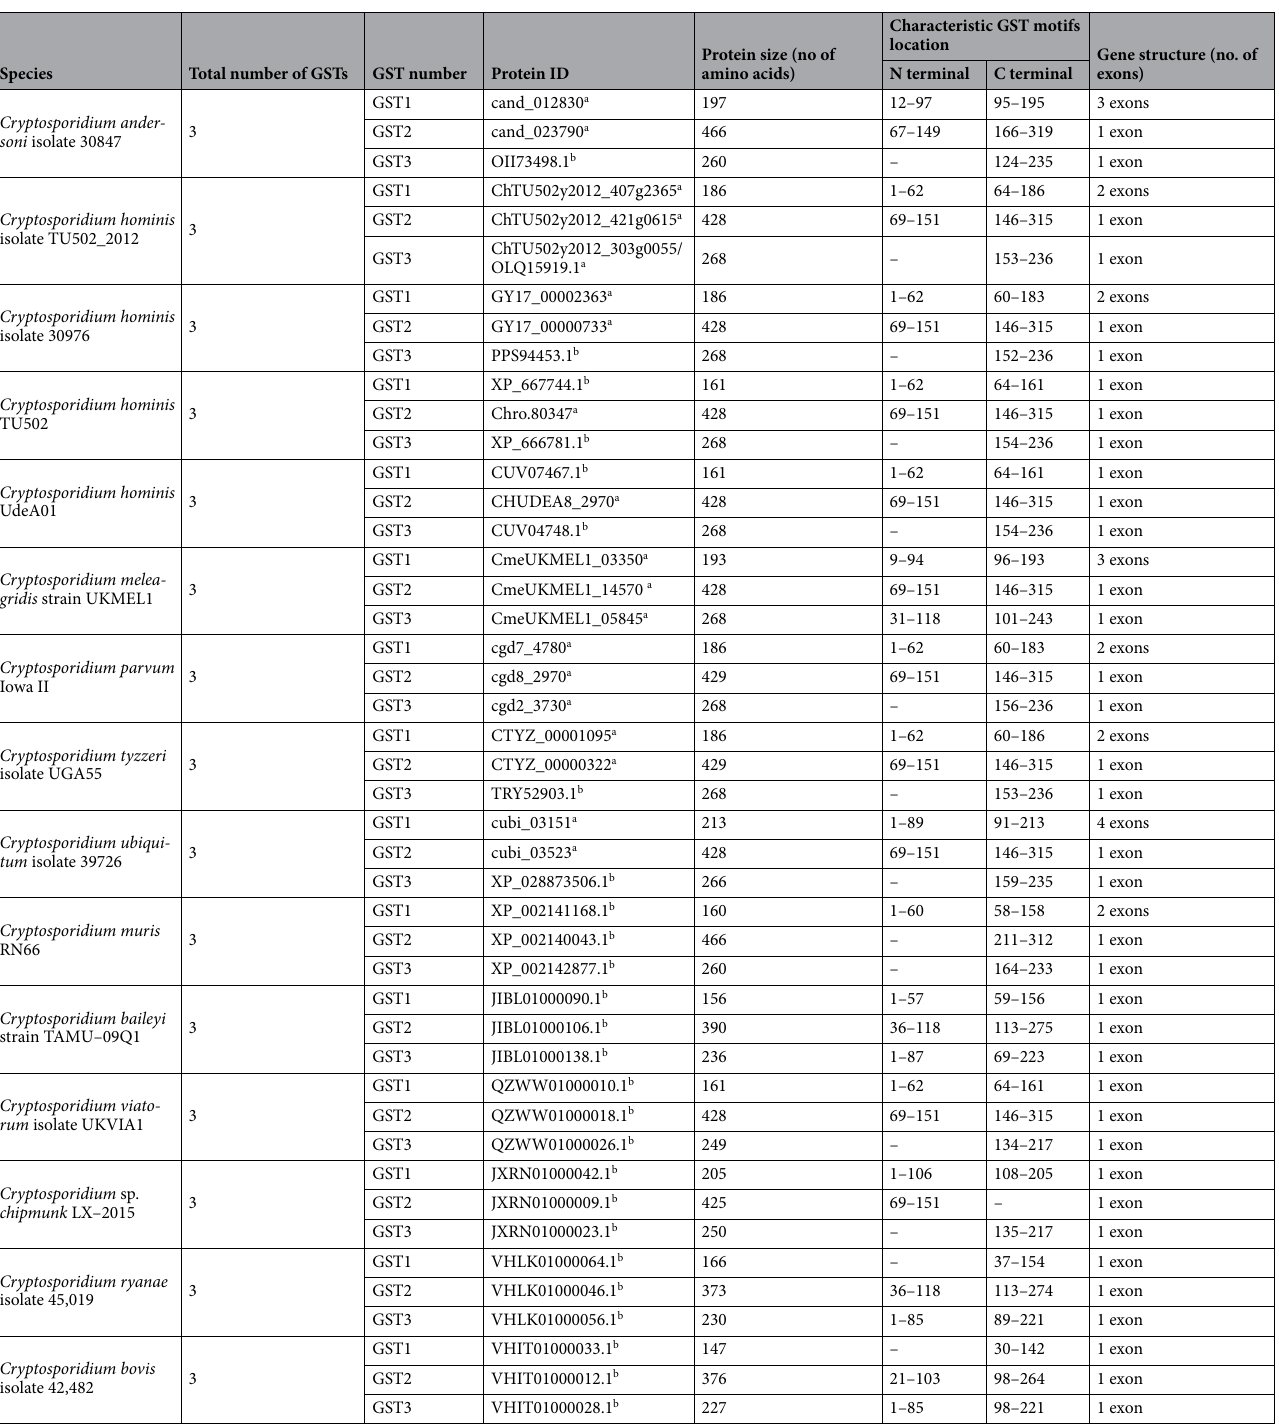
Table 2. Glutathione transferase (GST) analysis in Cryptosporidium species. The GST number in column 2 is an indication of the number of GSTs that a specific species possesses. Whilst the number on column 3 indicates the group the protein belongs to (based on the percentage identity) 20,23,26–28 . a Protein ID from CryptoDatabase. b Protein ID from NCBI database. –, characteristic GST domain not